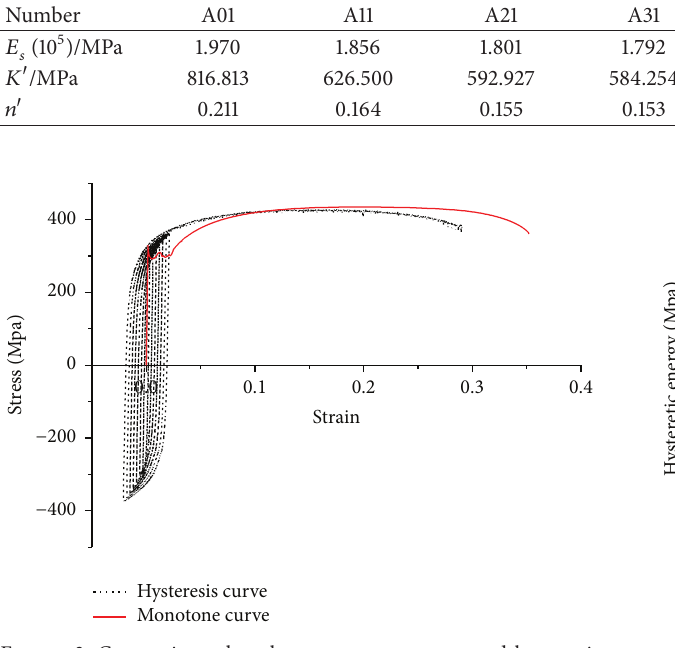
Table 2: Skeleton curve model.